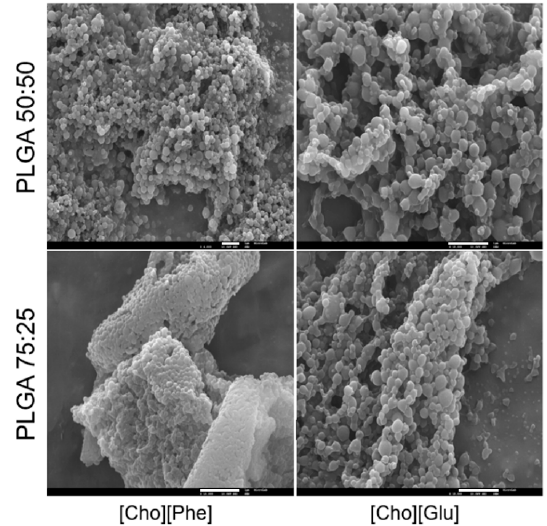
Figure 5. SEM microphotographs of rutin-loaded IL-polymer nanoparticle hybrid systems after freeze-drying at a magnification of 4000× (PLGA 50:50/[Cho][Phe]) and 10,000× (remaining images). The scale bar of the microphotographs at the bottom right of the images corresponds to 2 µm.